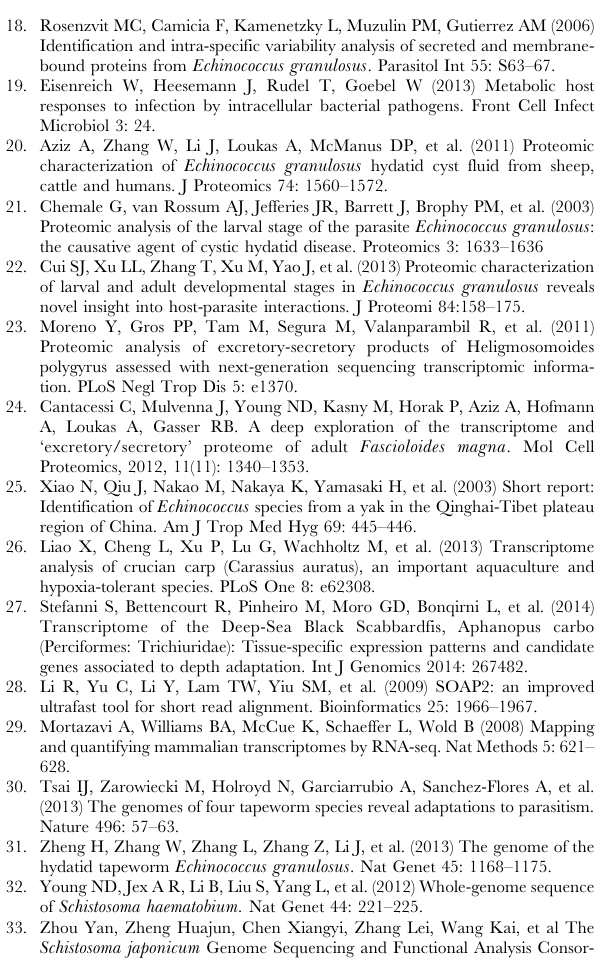
S6 Table Domains of the proteases and protease inhibitors in the ESPs. (XLSX) S7 Table Overview of the KEGG pathways involved in the predicted ESPs. (XLSX) S8 Table The most abundant transcripts in the ESPs of the Eg PSCs based on RPKM (reads per kilobase per million reads). (XLSX) S9 Table The proteins that were significantly enriched in the KEGG pathways of the predicted ESPs.